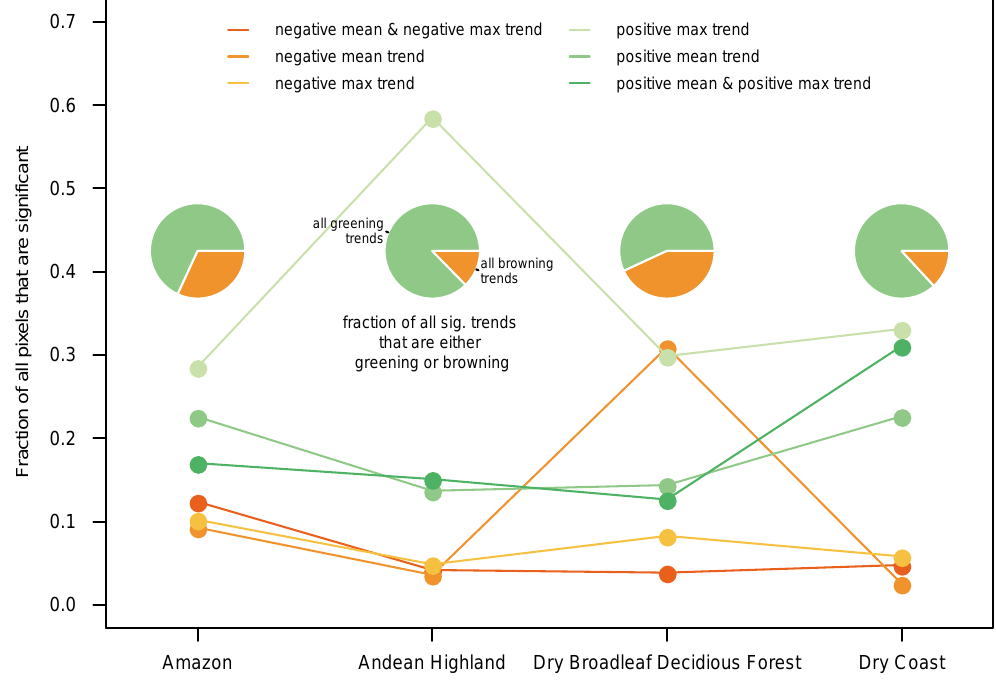
Figure 4. Greening and browning trends by biome. Greening outpaces browning in the Amazon, Andean Highlands, and Dry Coast. Refer to Table 1 for greening and browning confidence